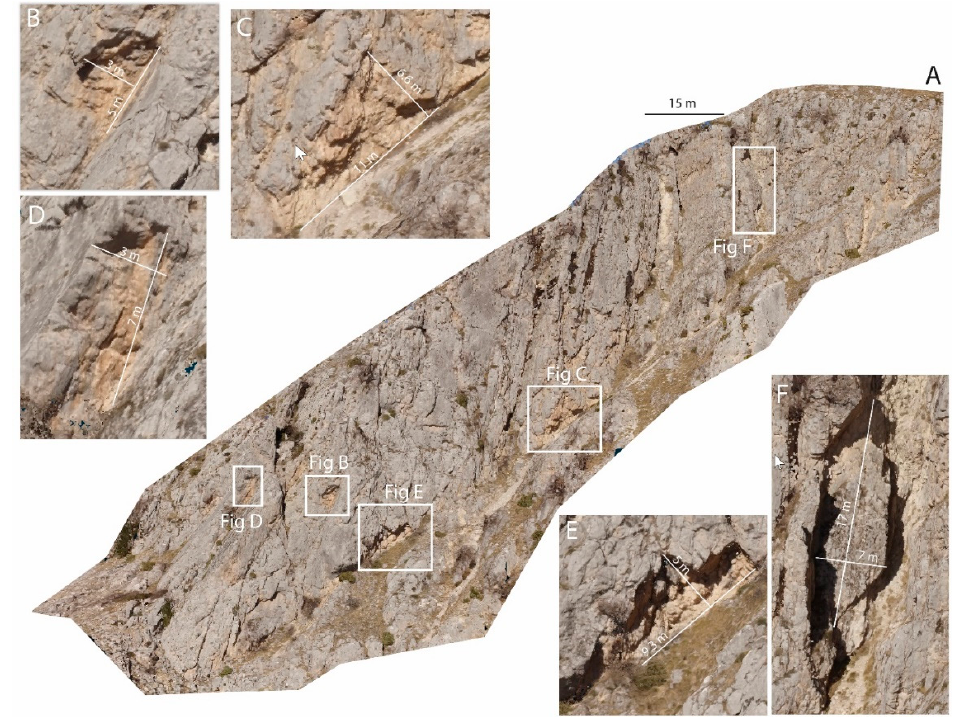
Figure 17. The 3D model of the area UAV 2 ( A ), examples of rockfall scars ( B-E ) and a suspended block ( F ). The calculated volume of failed blocks associated with such scars is ca. 40 m 3 (Figure 17B), ca. 200 m 3 (Figure 17C), ca. 60 m 3 (Figure 17D) and ca. 230 m 3 (Figure 17E). Figure 17F highlights the volume of overhanging block with a volume of ca. 500 m 3 .